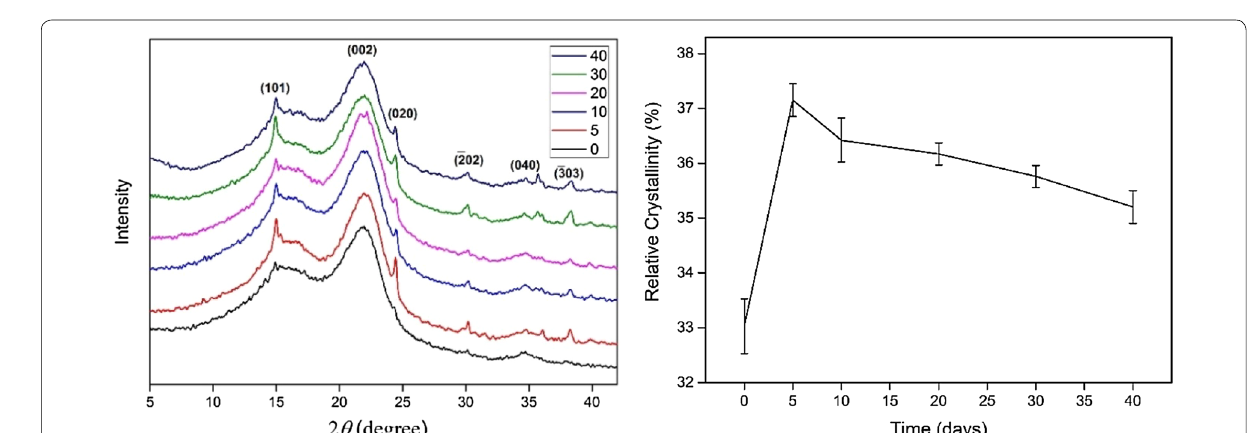
Fig. 2 XRD curves and relative crystallinity of rubberwood dyed with fungi from 0 to 40 days. The results represent the mean